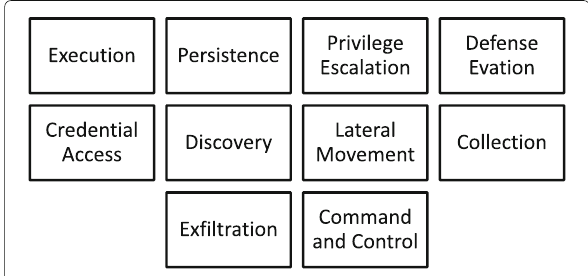
Fig. 1 Adversary enterprise tactics according to MITRE’s ATT&CK framework